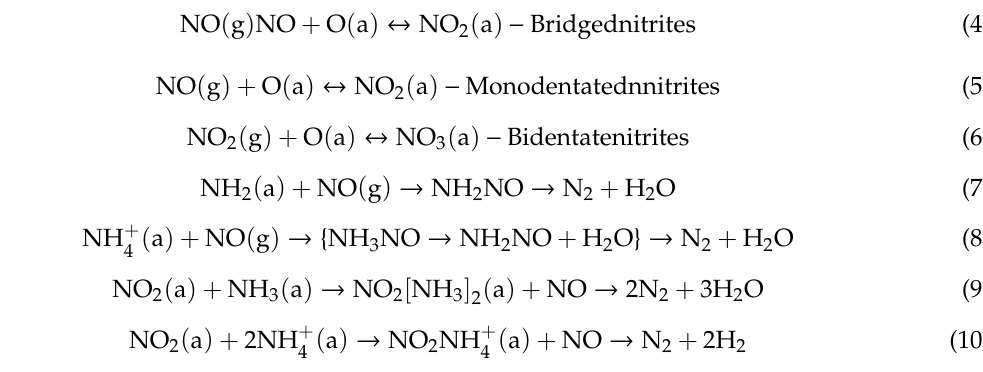
Figure 5. The influence of acidity of SSOC on SCR performance.